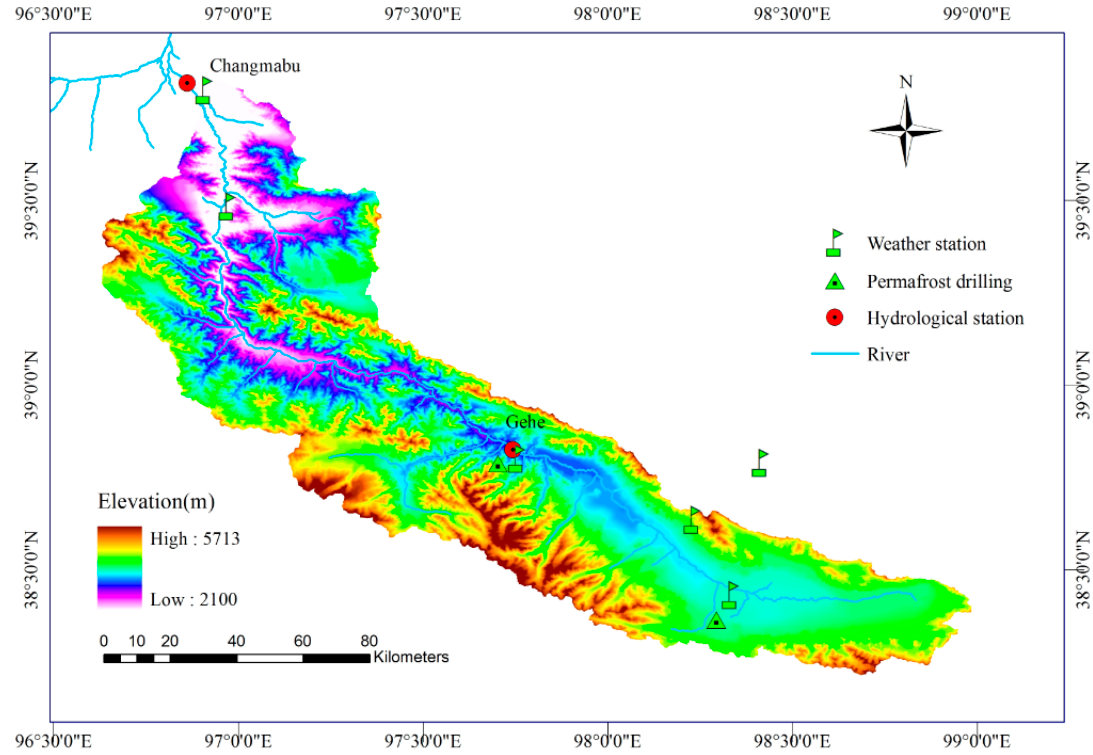
Figure 1. Locations of the study area and its elevation.